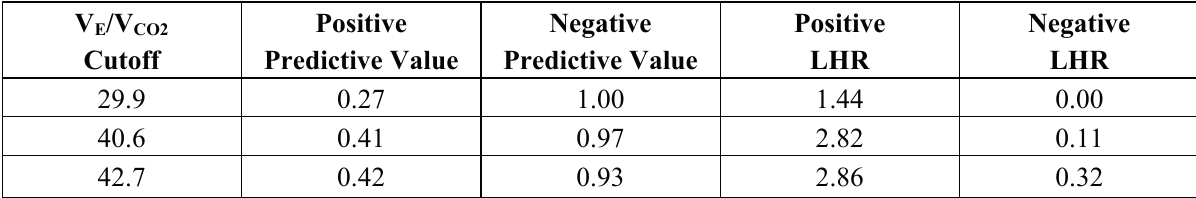
Table 4. Operating characteristics of V E /V CO2 in predicting the highest risk category (RRRS ≥ 10). LHR, likelihood